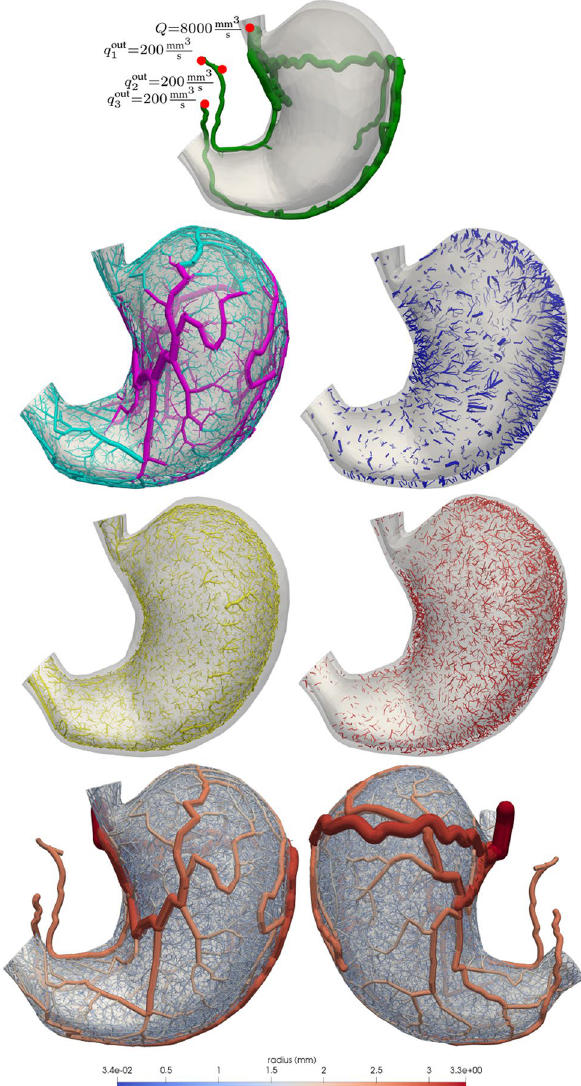
Figure 8. Stomach vasculature generated by a five-staged growth process: (first row) initial tree T 0 , including the inflow and outflow constraints; (second and third rows) from left to right and top to bottom, vessels corresponding to the serosa layer ( T 1 ∪ T 2 ), muscularis perforators ( T 3 ), mucosa layer ( T 4 ) and muscularis layer ( T 5 ); (bottom row) final vascular tree depicting the vessel radius from anterior and posterior views of the stomach. Images generated with ParaView version 5.4 available at https ://www.parav